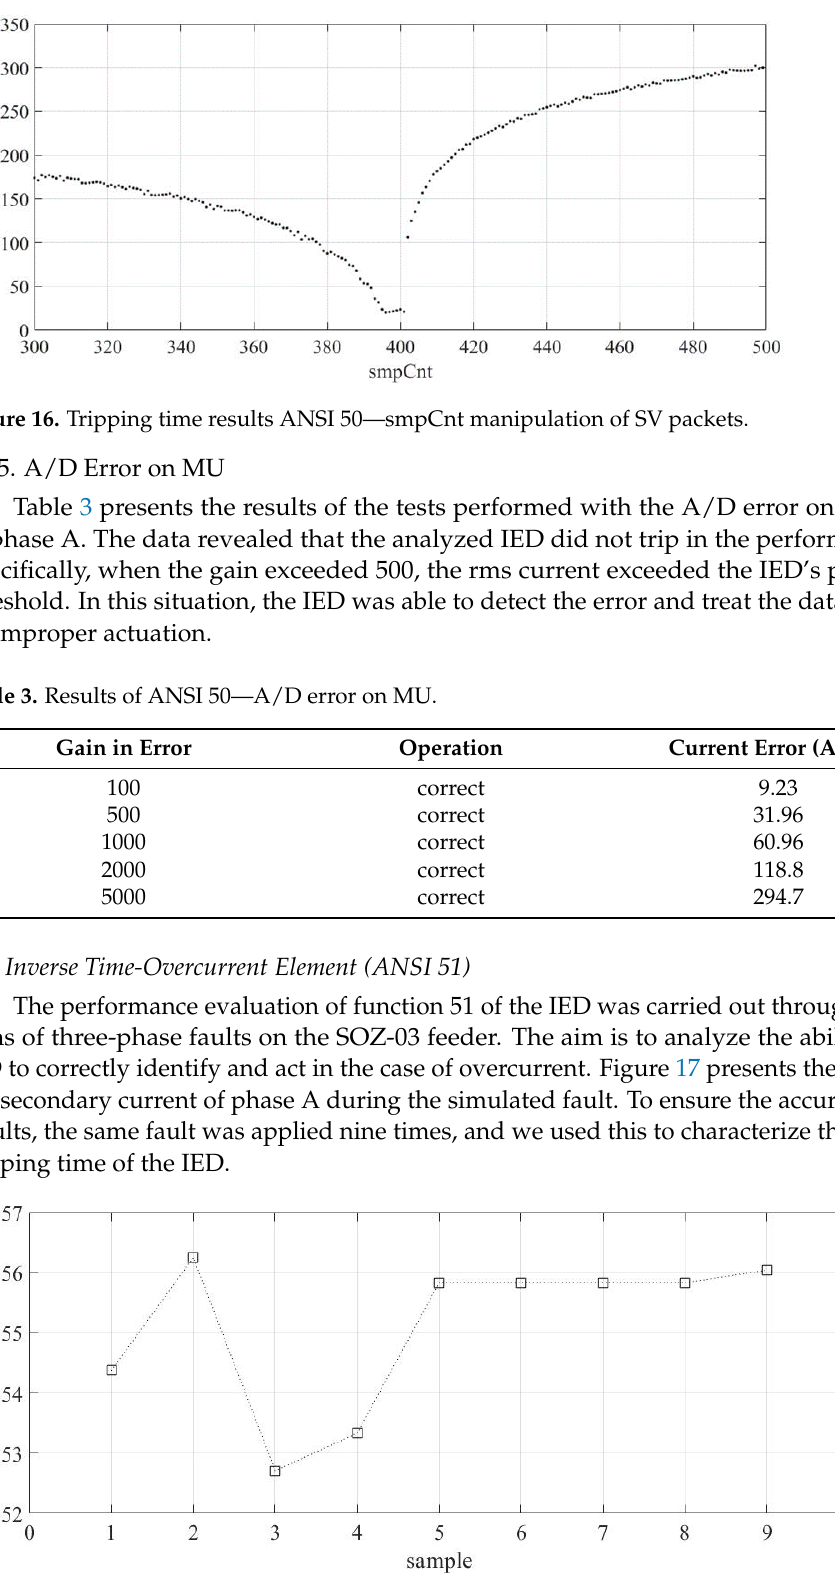
Figure 17. Tripping time (IED processing + GOOSE) for ANSI